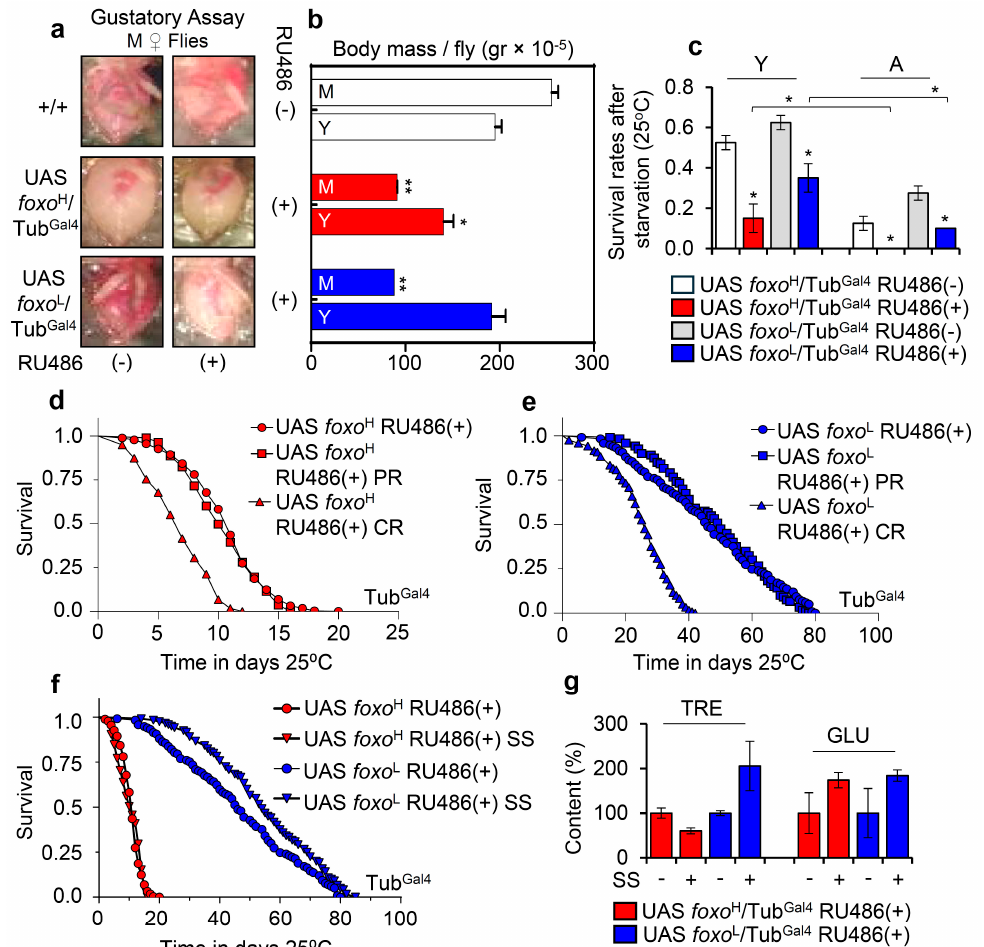
Figure 3. foxo OE exhausts flies’ energy stores, reducing tolerance to nutritional deprivation; a phenotype that can be partially rescued by increased calories intake. ( a ) Representative dissected abdomens from middle-aged (M) female foxo overexpressing flies vs. controls (including w 1118 flies) following gustatory assay to test food intake. ( b ) Measurement of body mass per fly (gr × 10 − 5 ) of young (Y) and middle-aged (M) foxo overexpressing flies (bars are as in c ). ( c ) Survival rates after starvation of young (Y) or aged (A) foxo overexpressing transgenic flies. ( d , e ) Longevity curves of shown foxo overexpressing transgenic flies after nutritional deprivation (CR, calories restriction; PR, protein restriction). ( f ) Longevity curves of foxo overexpressing flies following sugar over-supplementation (SS). Statistics of longevity assays are reported in Table S1. ( g ) Relative content of TRE and GLU in isolated somatic tissues of aged foxo overexpressing flies after sugar over-supplementation; control values were set to 100%. Bars, ± SD; n ≥ 3, ≥ 5 flies were analyzed per experimental repeat. Statistical significance in ( b , c , g ) was calculated with unpaired t -test, * p < 0.05, ** p < 0.01.